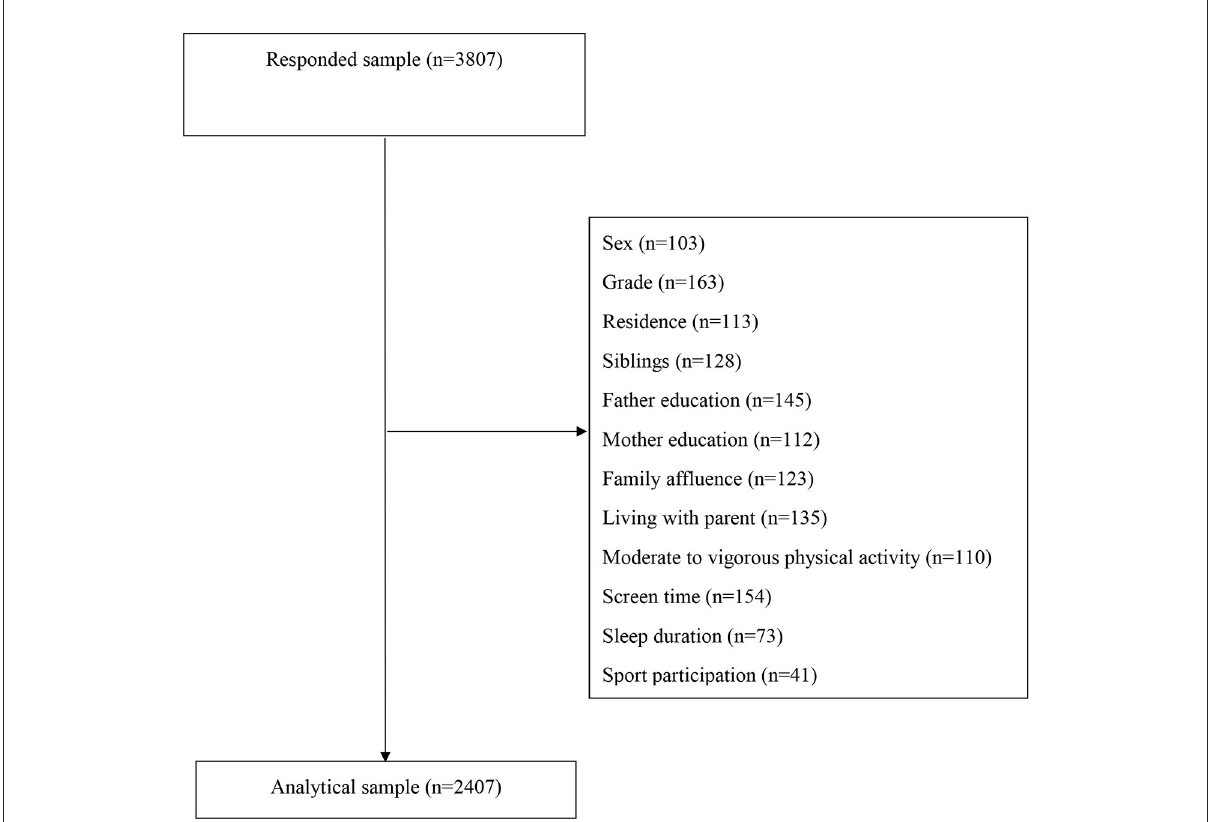
FIGURE1 The procedure used for cleaning invalid and missing data in this